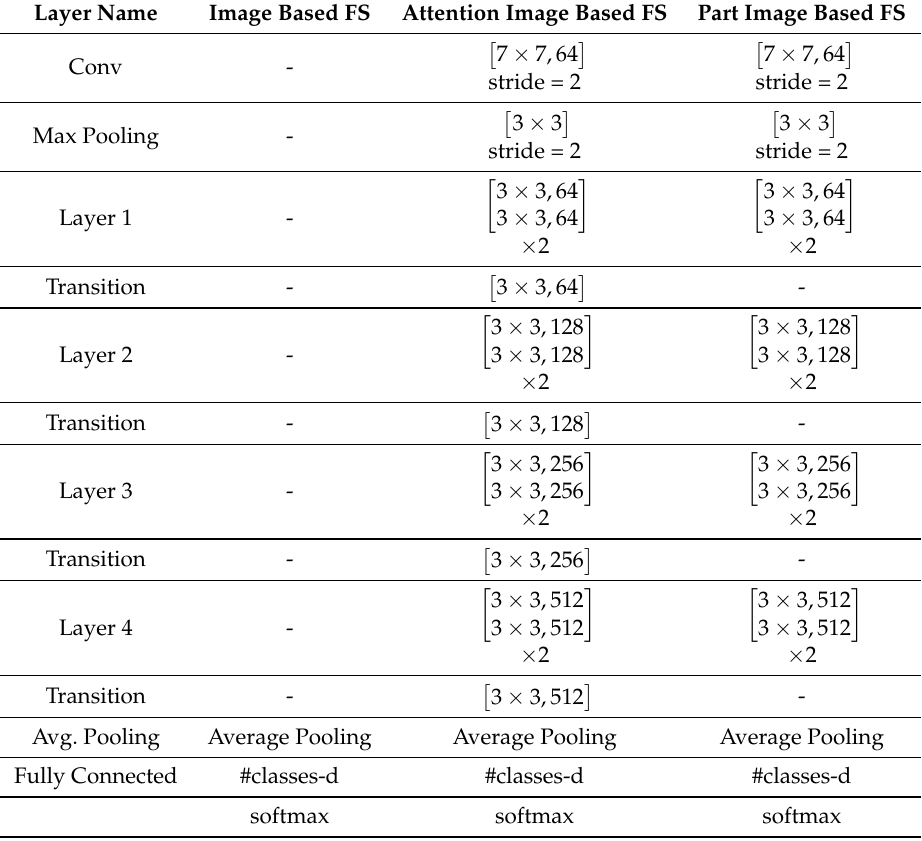
Table 1. Configuration of the three feature streams (FS) in the proposed method for action recognition. Attention image-based FS and part Iimage-based FS are based on ResNet18 [23]. The layer names are the same as in Figures 2–4 (see [23] for more details). Notably, there are additional transition layers unlike ResNet18